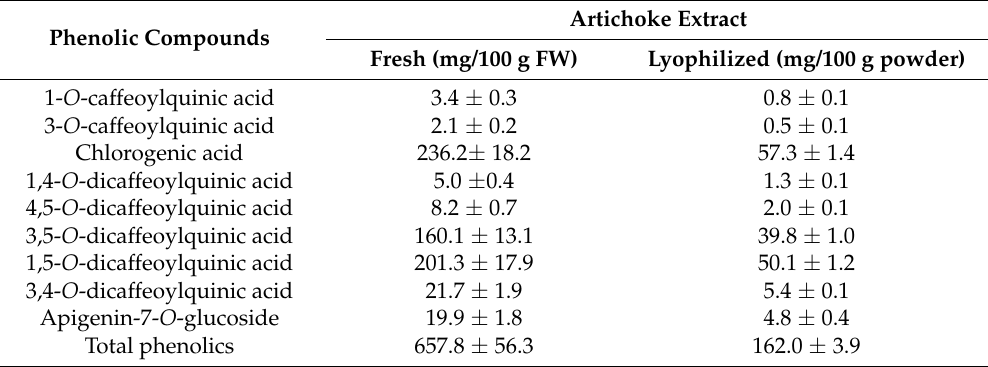
Table 1. Polyphenol composition of the artichoke head extract before and after lyophilization, performed by HPLC-DAD